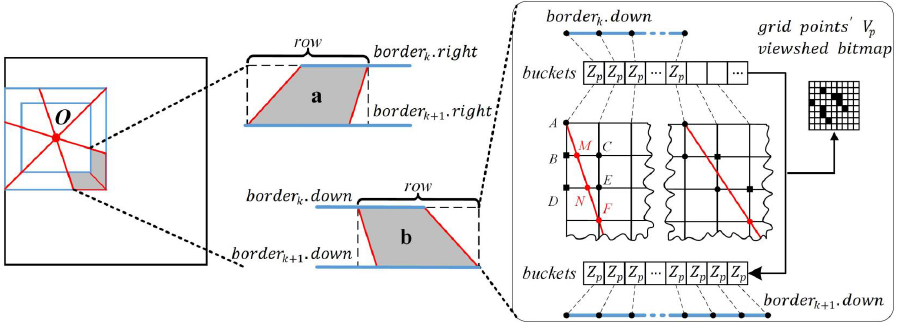
Figure 7. The Boundary Approximate Calculation